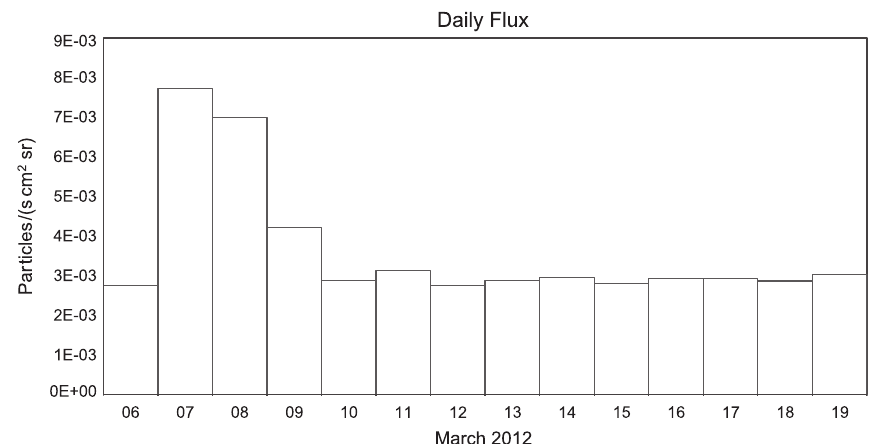
Fig. 8. Daily flux rate recorded by ALTEA SDU1 between March 6th and March 19th,